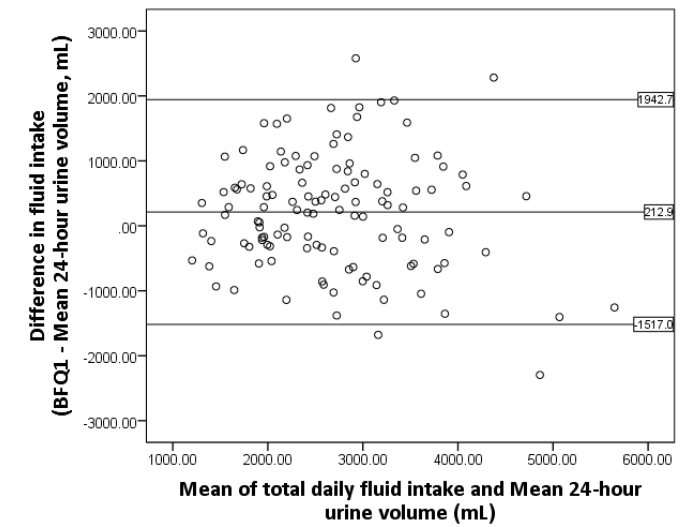
Figure 2. Bland–Altman plots of total daily fluid intake and ( a ) First 24-h urine volume, ( b ) Second 24-h urine volume, and ( c ) Mean 24-h urine volume with 95% limits of agreement.